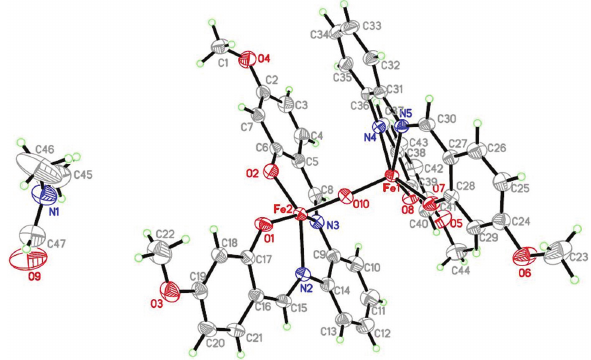
Table 1: Data collection and handling.